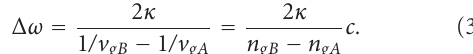
Weak-coupling analytical curve Peak transmission data from FDTD